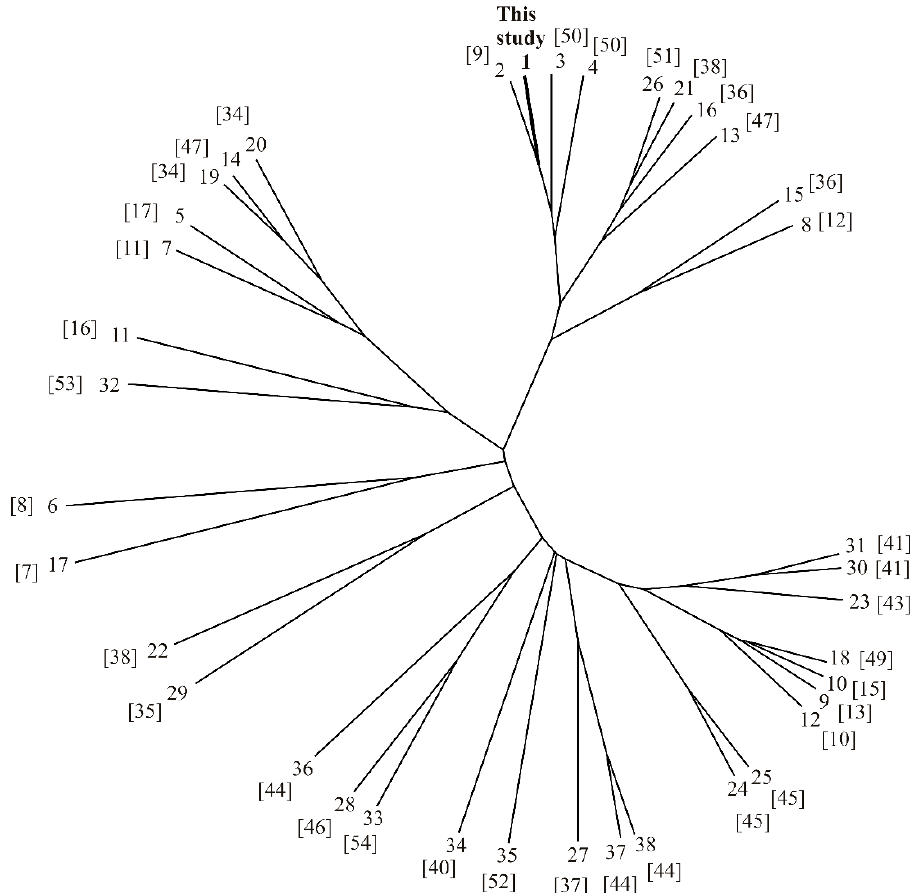
Figure 4. Unrooted cluster tree for different Marrubium samples.